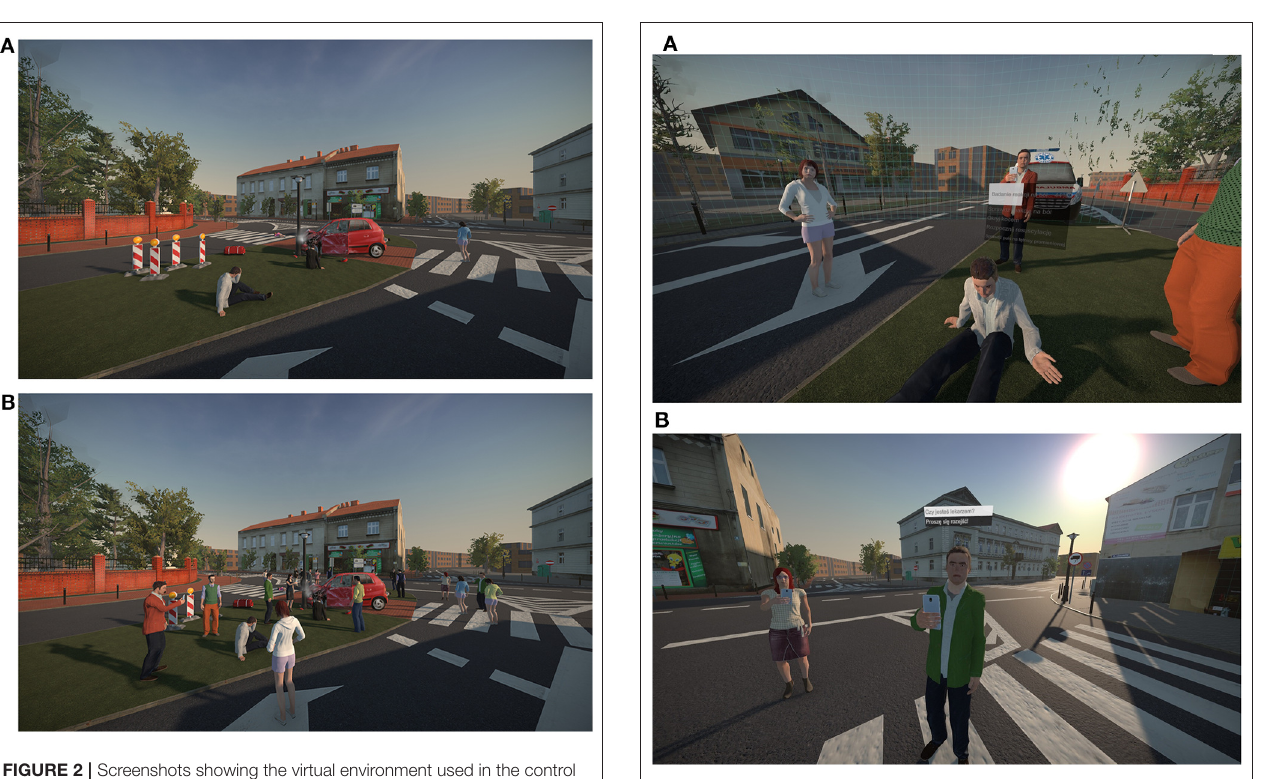
FIGURE 2 | Screenshots showing the virtual environment used in the control (A) and experimental condition (B) . This point of view was available for the participants.